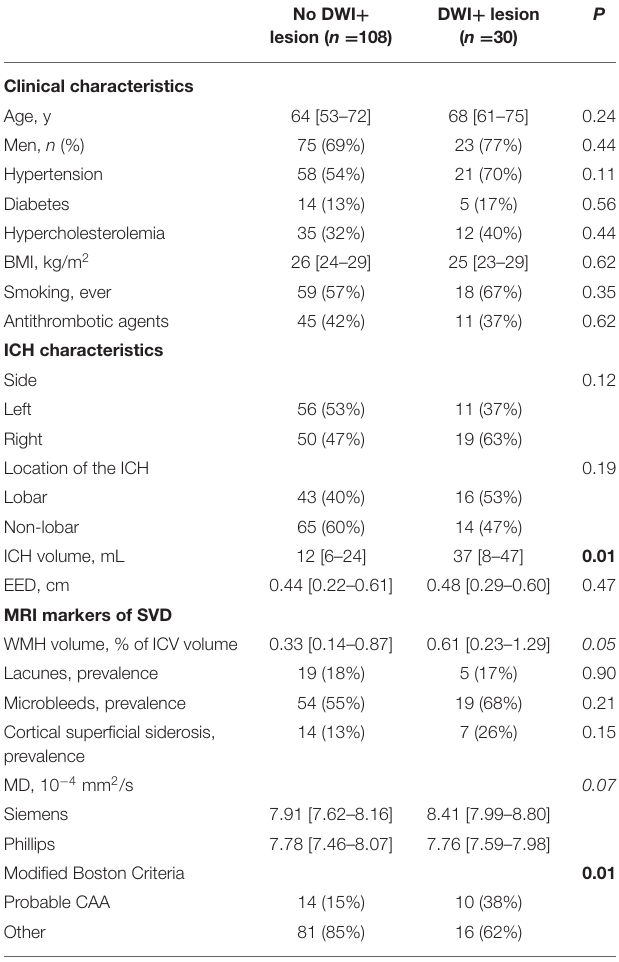
TABLE 1 | Characteristics of participants with and without DWI +